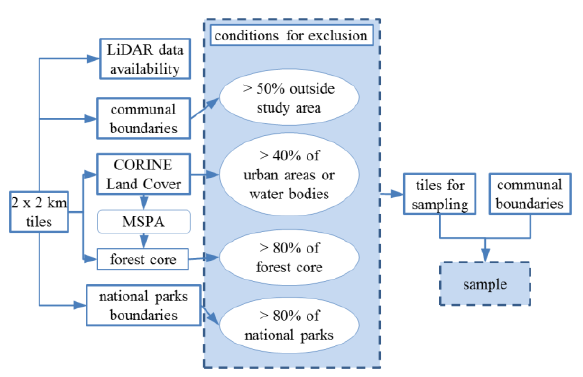
Figure 2. Workflow of the sampling strategy